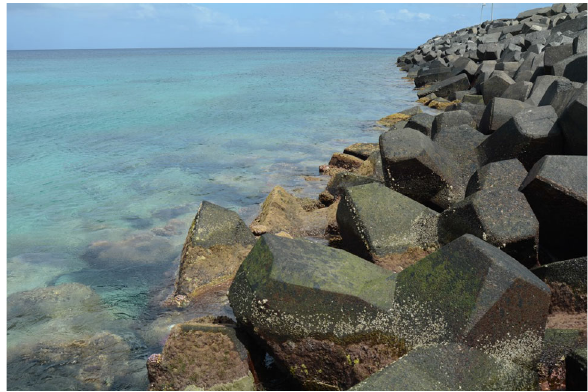
Fig. 1 Breakwaters of concrete with 30% ferronickel slag aggregate in marine exposure for 20